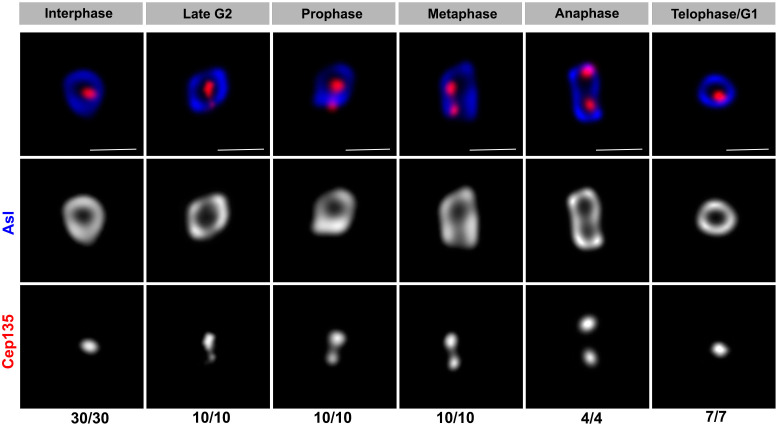
Stimulated emission depletion (STED) super-resolution images of endogenous Asl and Cep135 localization throughout the cell cycle in germline stem cells (GSCs).Red: Cep135. Blue: Asl. Bar: 0.5 μm. n = GSC centrosomes numbers scored for each panel.